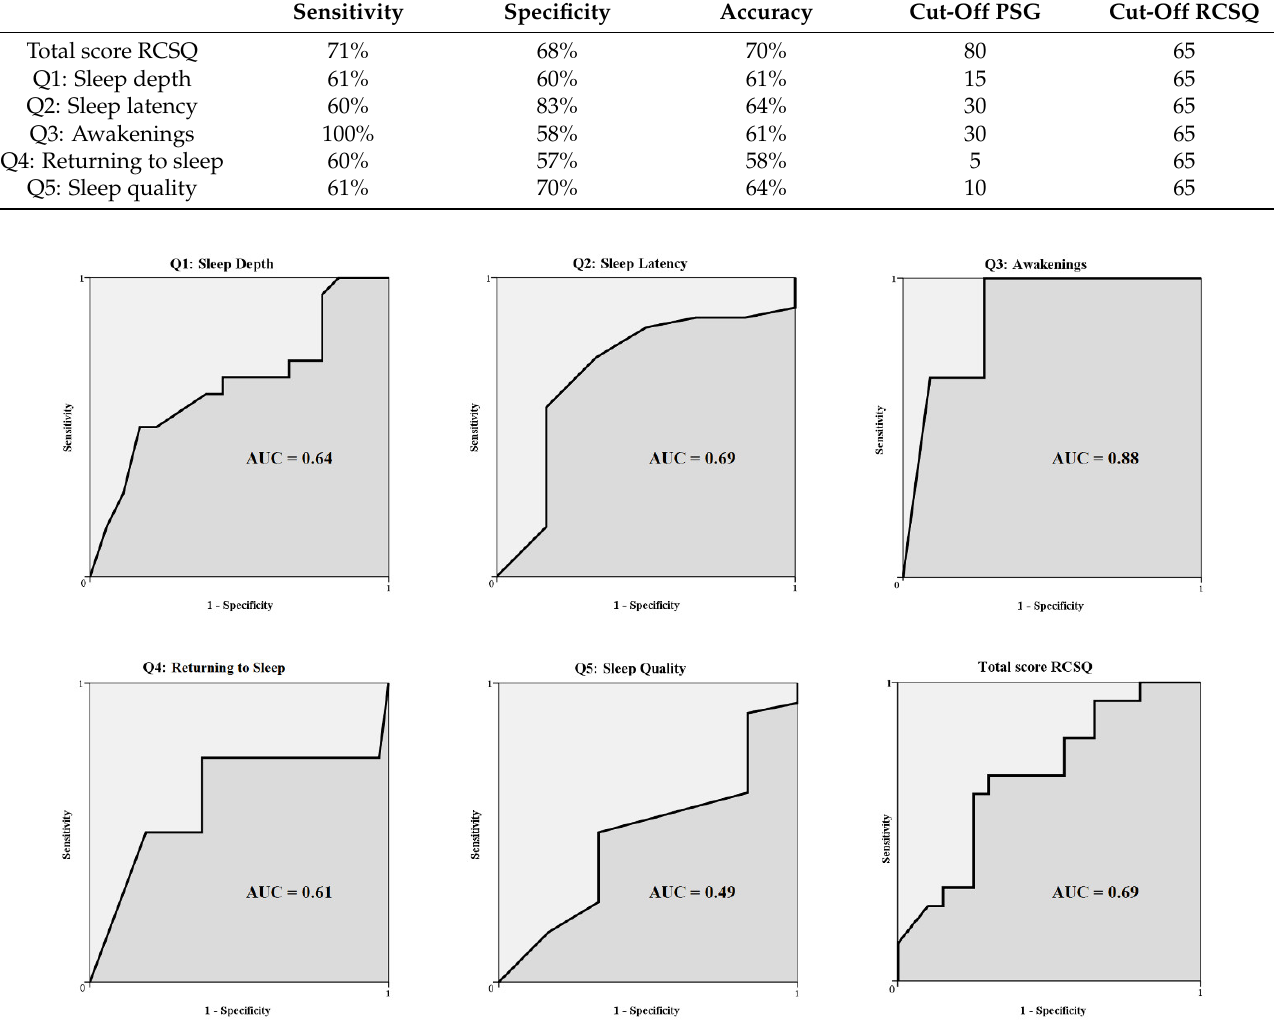
Figure 3. Receiver Operator Characteristic (ROC) curves for the different Richards-Campbell Sleep Questionnaire items and total score. AUC: area under curve.